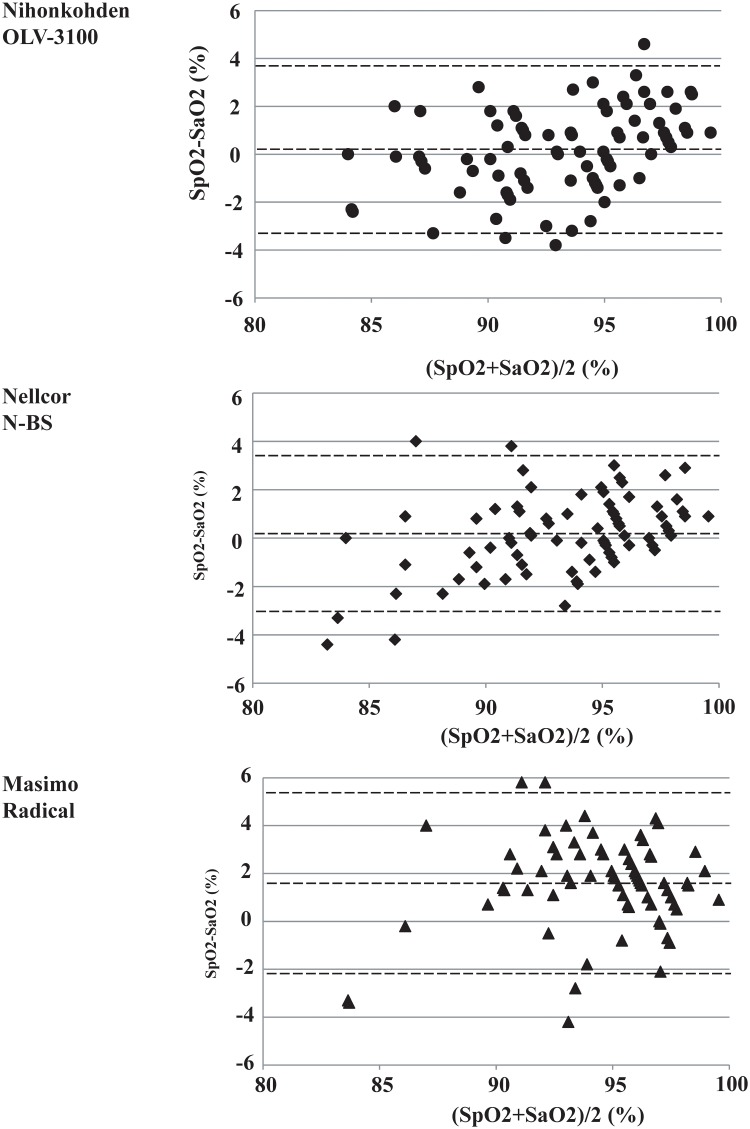
Bland Altman plot comparing SaO2 (oxyhemoglobin saturation measured by blood gas analyzer (ABL 825)) and SpO2 (oxyhemoglobin saturation measured by 3 pulse oximeters).For each data point, the mean value ([SpO2 +SaO2]/ 2) is presented on the x-axis, and the difference value (SpO2—SaO2) on the y-axis. Black lines represent the 95% confidence interval for SpO2 [bias ± 2 standard deviation (SD)]. The mean difference value (SpO2—SaO2) represents the bias, and SD represents the precision. Oximeters are: A. Nihonkohden OLV-3100, B. Nellcor N-BS, and C. Masimo Radical. Bias was 0.19% +/- 1.79% (mean +/- SD) by Nihonkohden oximeter, 0.18% +/- 1.64% by Nellcor oximeter, and 1.61% +/- 1.93% by Masimo oximeter.